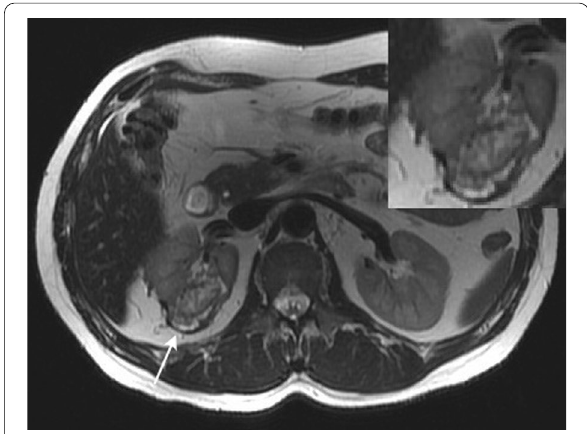
Fig. 4 Follow-up MRI at 3 months. Axial T2WI sequences highlighting a hypointense rim (arrow) in the posterior–superior aspect of the right perirenal space, most likely indicating benign fibrotic